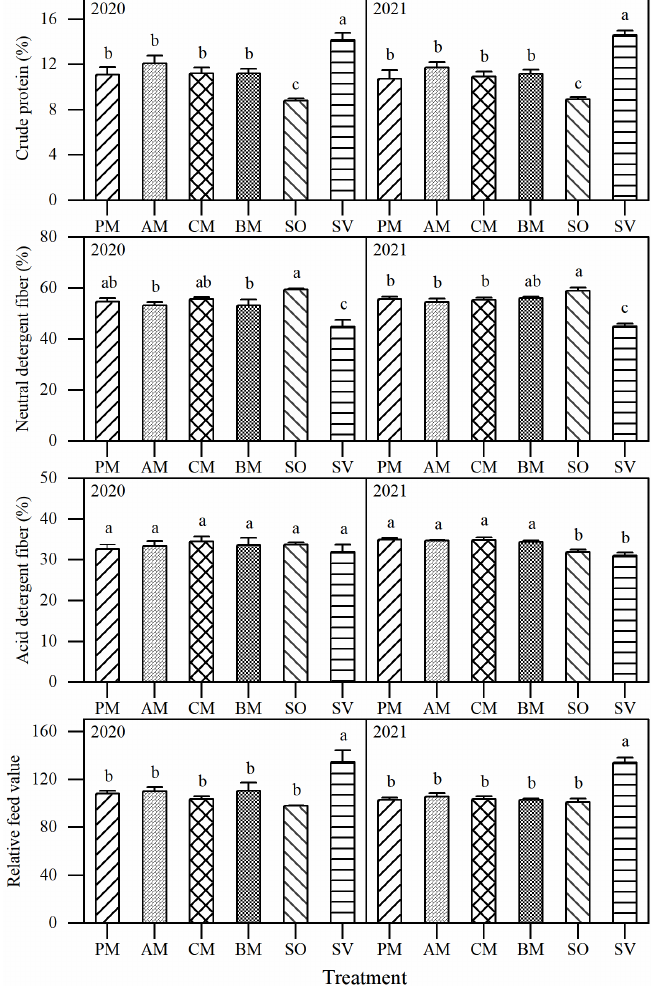
Figure 4. Crude protein content (CP), neutral detergent fiber content (NDF), acid detergent fiber content (ADF), and relative feed value (RFV) of mixed cropping systems among different cropping systems over two years in Yanchi county, Ningxia, China. Note: PM: peer mixing; AM: alternate-row mixing; CM: cross mixing; BM: bar mixing; SO: sole forage oat; SV: sole common vetch. Different lowercase letters indicate significant difference at p < 0.05.